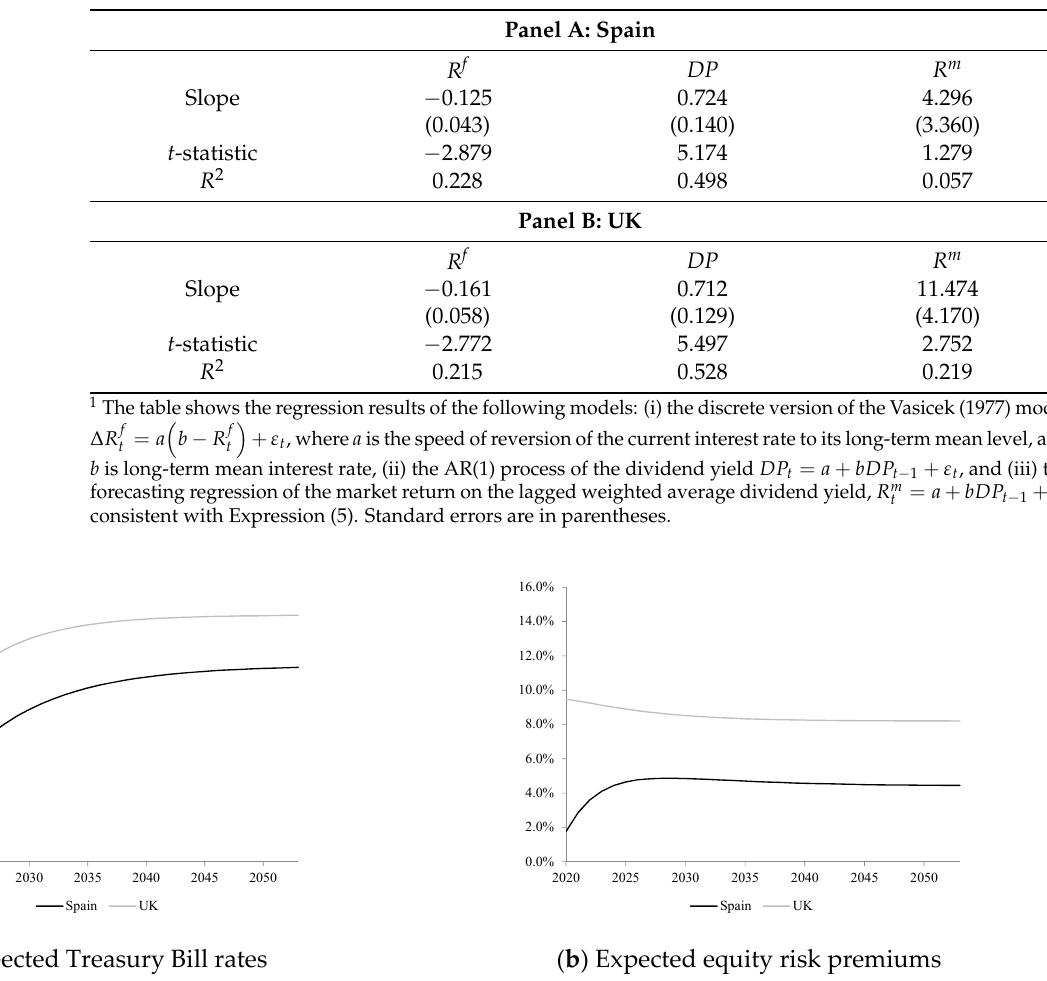
Figure 2. Main aggregates of the cash flow waterfall for the base case. Table 7. Forecasting regressions.